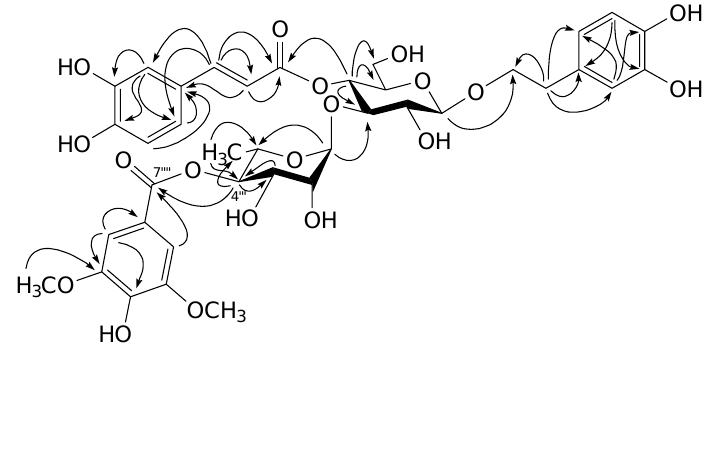
Figure 2. The HMBC correlations of acanmontanoside ( 1